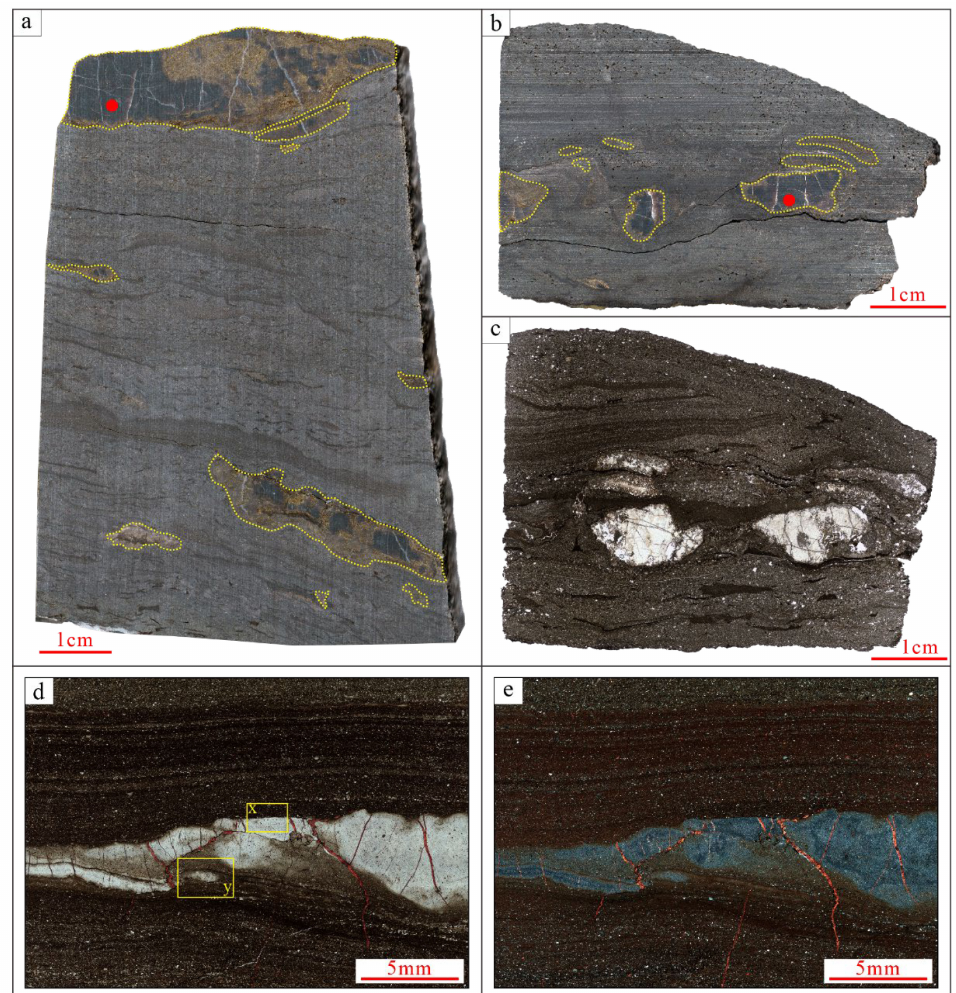
Figure 3. Photographs and optical photomicrographs of chert nodules in the Lucaogou Formation from the Junggar Basin, NW China. Chert nodules are circled by yellow dotted lines in ( a , b ). ( a ) Fresh surface of sample cut by diamond wire saw; the position of sample C-01 is shown in the red dot; ( b ) fresh flat surface of sample cut by diamond wire saw; the position of sample C-07 is shown in the red dot; ( c ) plane-polarized photograph of chert nodule; ( d ) plane-polarized photograph of chert nodule; ( e ) cross-polarized photograph corresponding to ( d